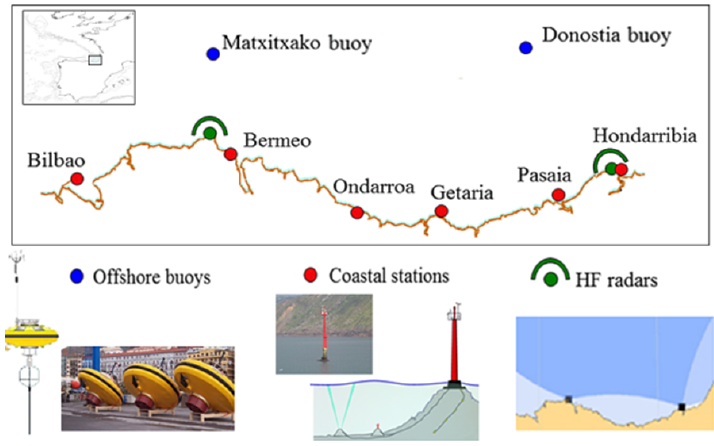
Figure 1. Ocean–meteorological coastal Basque government network.